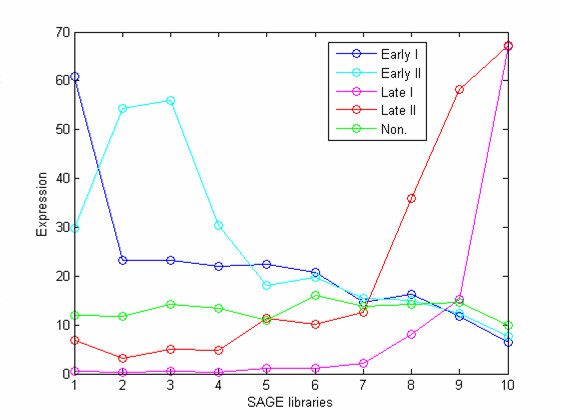
Average expression profiles for the 153 SAGE tags. These 153 tags fall into 5 clusters: 125 of these genes are developmental genes and can be further categorized into four groups (Early I, Early II, Late I and Late II) by their expressions at different developmental stages; the other 28 genes are not relevant to the mouse retina development.